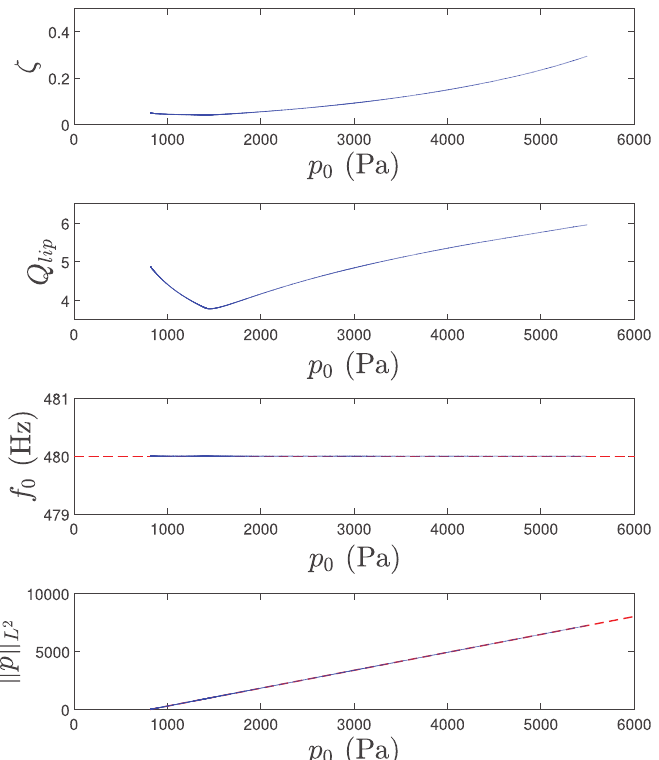
Figure 11. Bifurcation diagram with constraints and evolution of the relaxed parameters f and Q l with respect to p 0 . The target diagram is represented by the red dashed line.